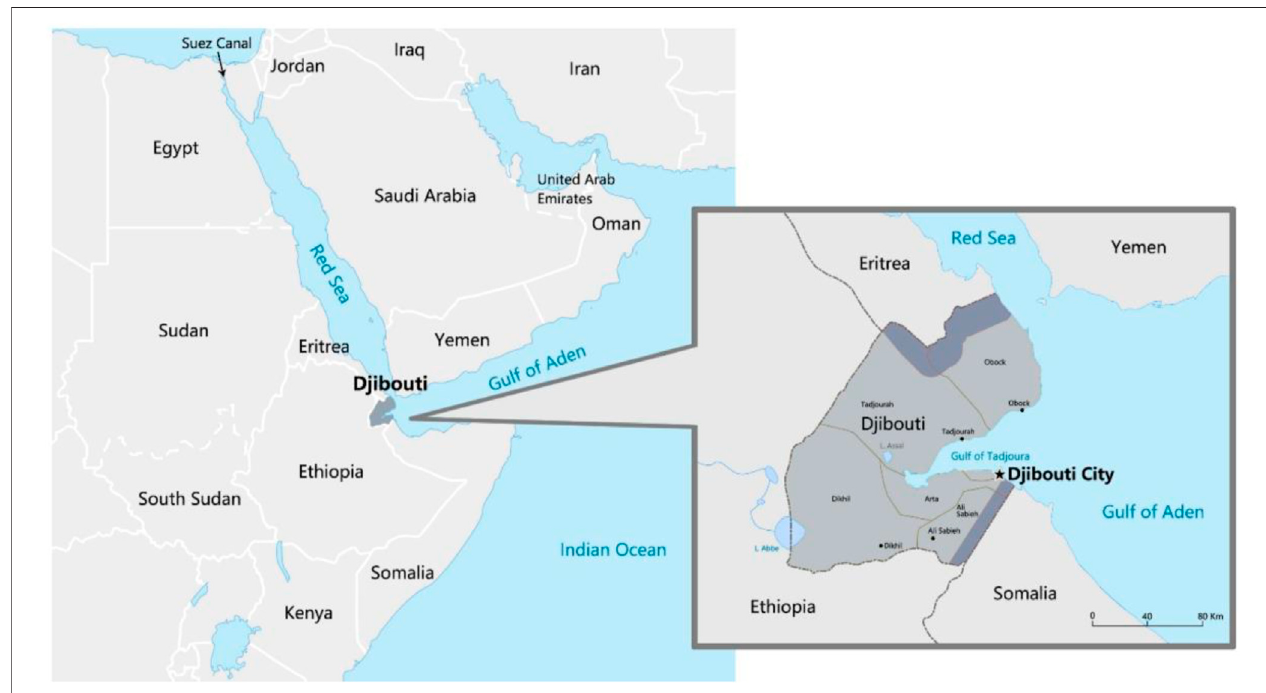
FIGURE 3 | Djibouti city